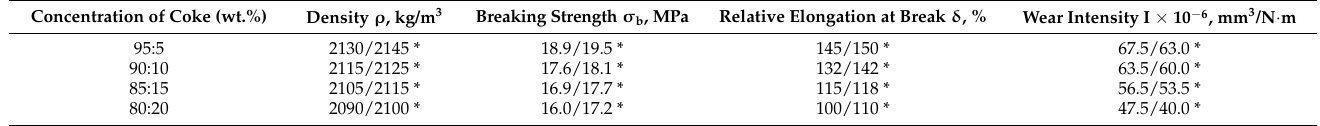
Table 2. The effect of coke concentration on the properties of PTFE composites.